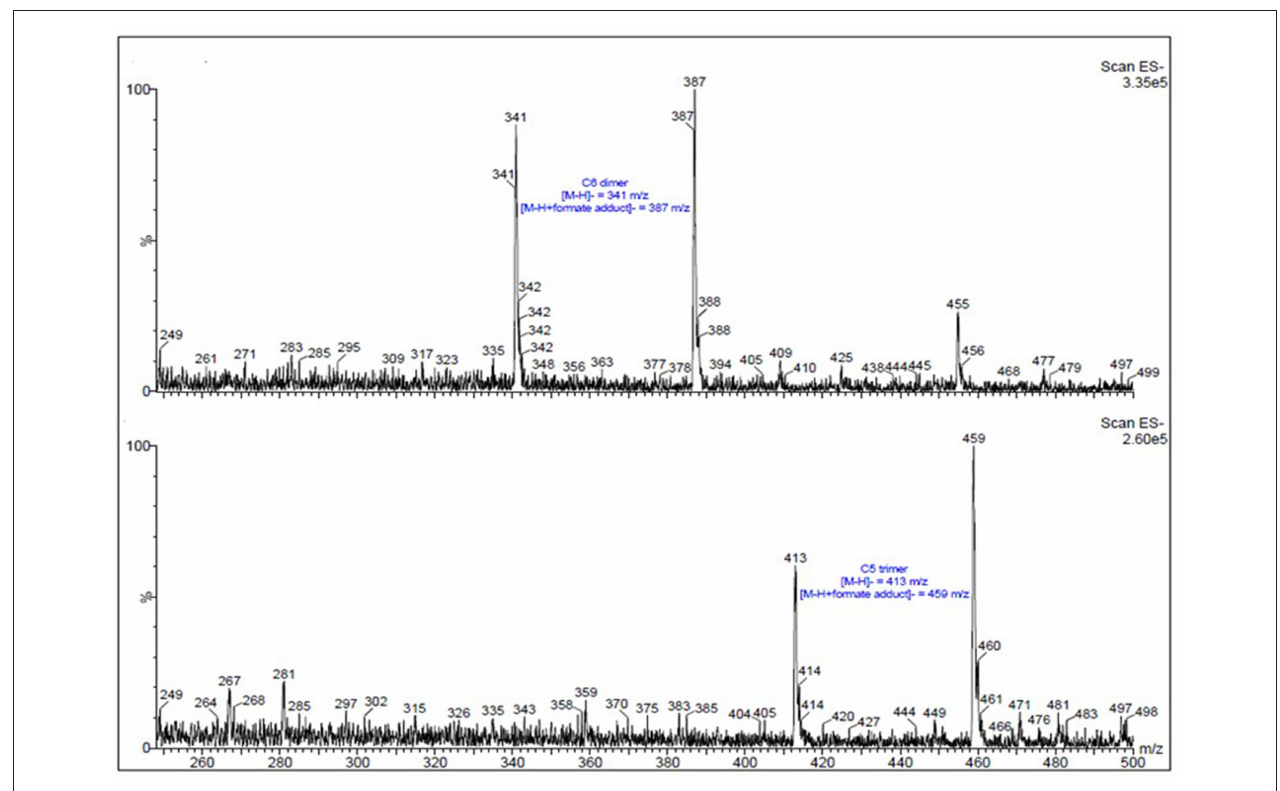
FIGURE 4 | MALDI TOF-MS spectrum of black liquor DMR BL-70.